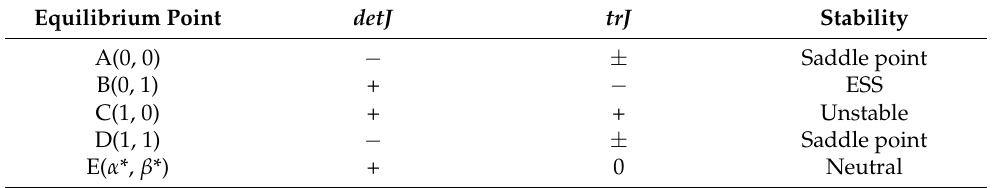
Table 5. Local stability analysis of scenario 3 between local government and coal-related enterprises. Equilibrium Point